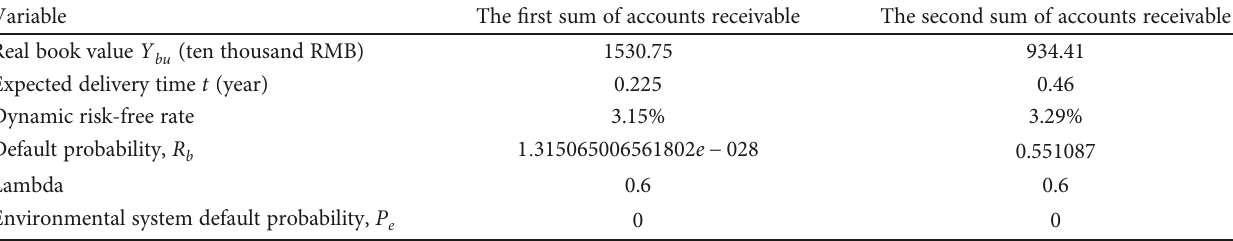
Table 9: Basic information of the accounts receivable of JDG company